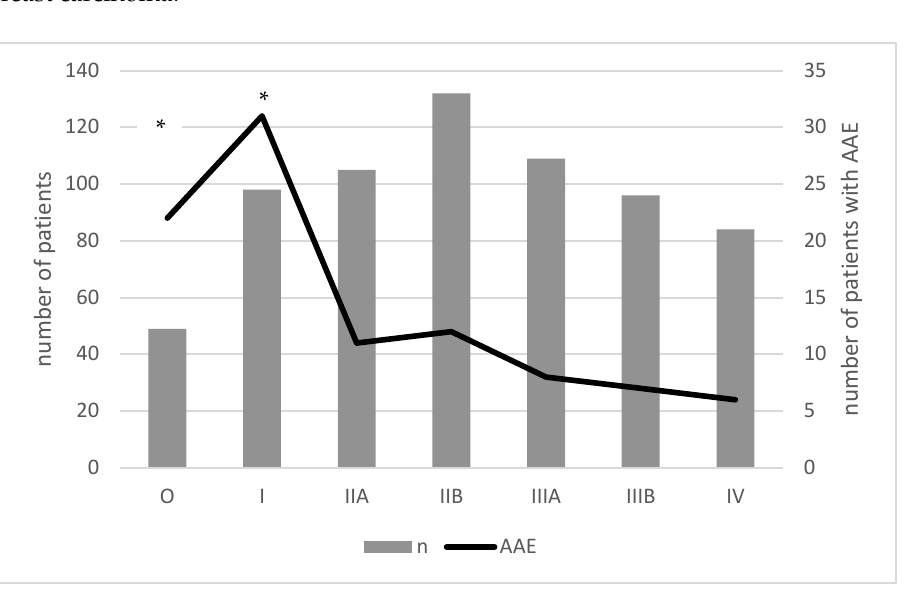
Figure 4. The incidence of C1-INH-AAE in patients with breast carcinoma according to TMN classifications. Legend: Stage 0: Tis; Stage I: T1N0; Stage IIA: T2N0, T3N0 T0N1; Stage IIA: T1N1, T2N1; Stage III: Invasion into skin and/or ribs, matted lymph nodes, T3N1, T0N2, T1N2, T2N2, T3N2, AnyT N3, T4 any N, locally advanced breast cancer; Stage IV: M1, advanced breast cancer; *—significant higher number of patients with incidence of C1-INH-AAE in 0 and I stage of